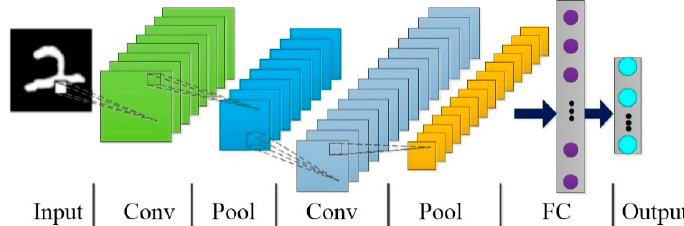
Figure 3. The typical structure of Convolutional Neural Network (CNN).